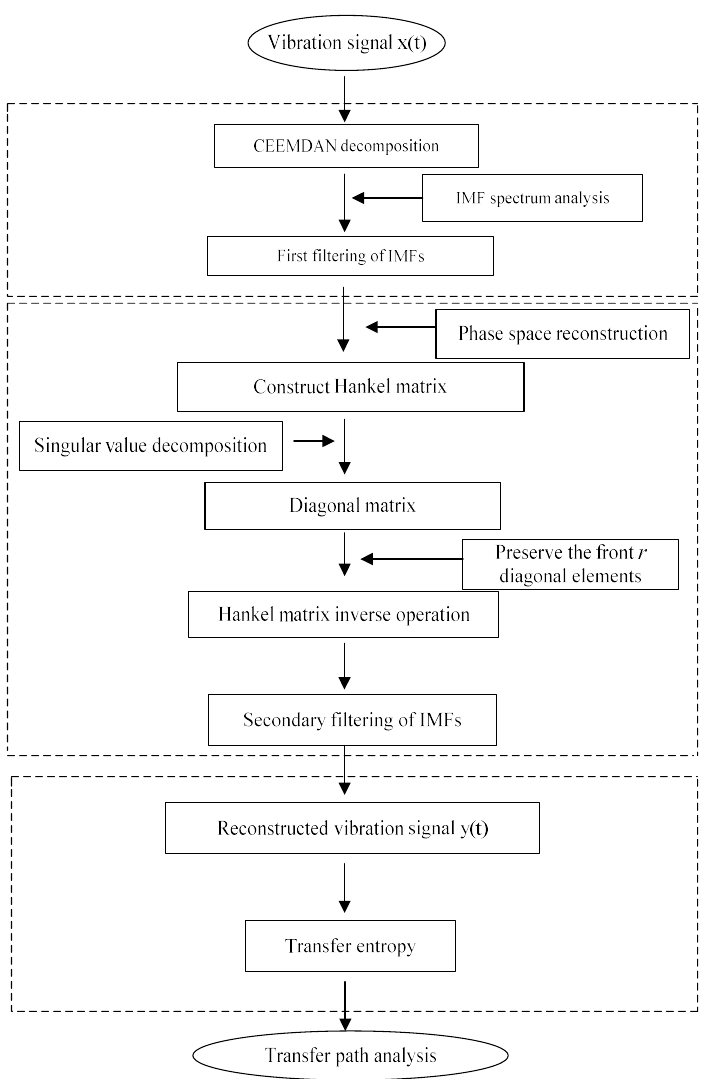
Figure 1. Flow chart of the CEEMDAN-SVD-TE method.